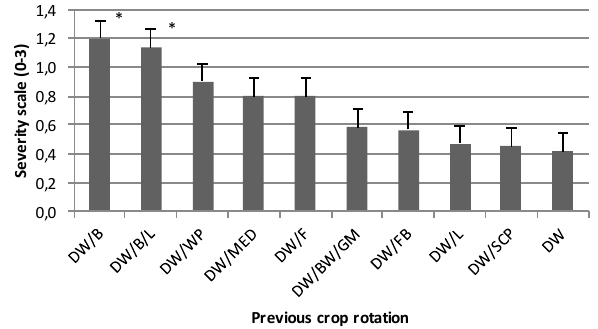
Figure 3. Impact of previous crops on durum wheat dis- ease severity of plants grown at in the Experimental Sta - tion of INRAT in Kef during the 2009–10 cropping season. Vertical bars: 2 × standard deviation. *: significant dif - ference ( P <0.05) compared to mono-cropping of durum wheat according to the Student test. DW: durum wheat; BW: bread wheat; B: barley; FB: faba bean; L: lentil; WCP: winter chickpea; SCP: spring chickpea; MED: medic; GM: green manure (faba bean); F: fallow.